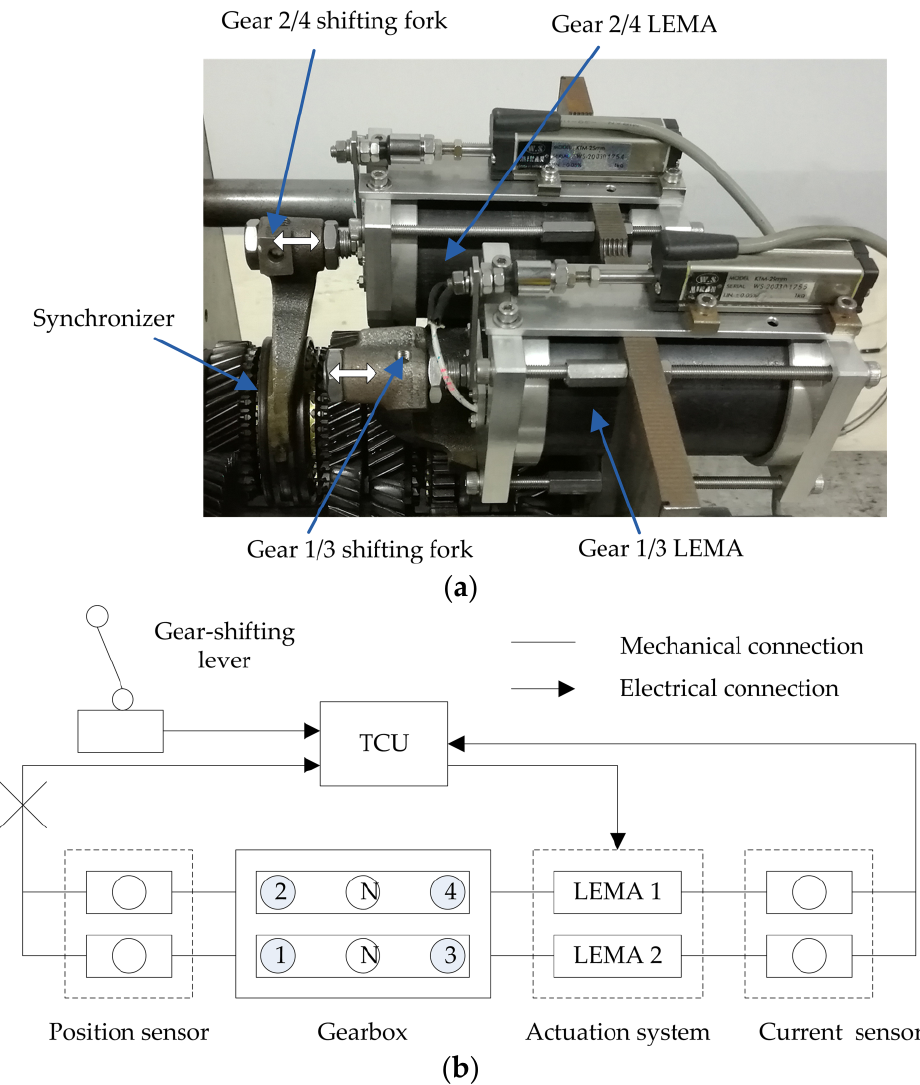
Figure 1. The independent gear ‐ shifting actuation system: ( a ) prototype; and ( b ) schematic diagram. LEMA: linear electromagnetic actuator; TCU: transmission control unit.